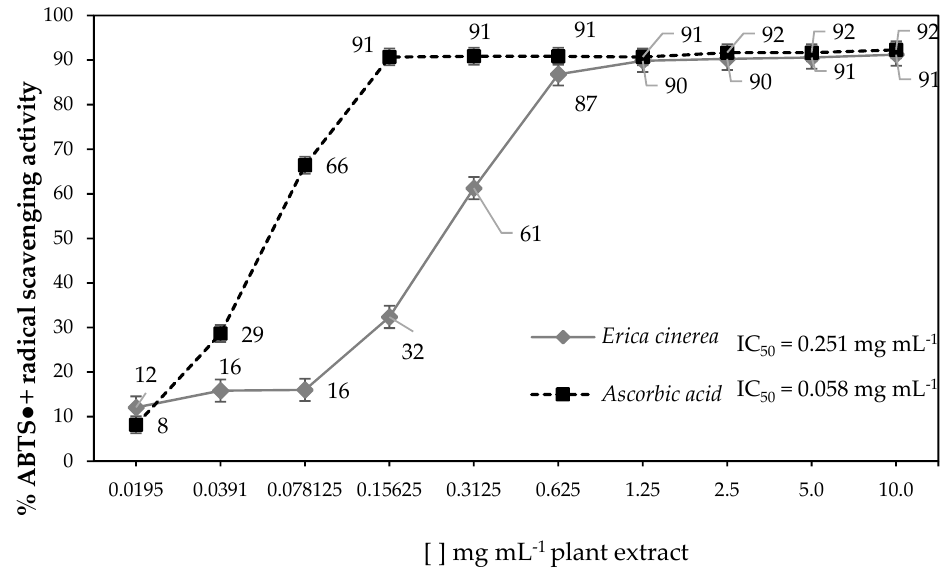
Figure 1. ABTS (2,2 ′ -azinobis-(3-ethylbenzothiazoline-6-sulfonic acid)) radical scavenging activity of E. cinerea and ascorbic acid at different concentrations, and respective IC 50 values.